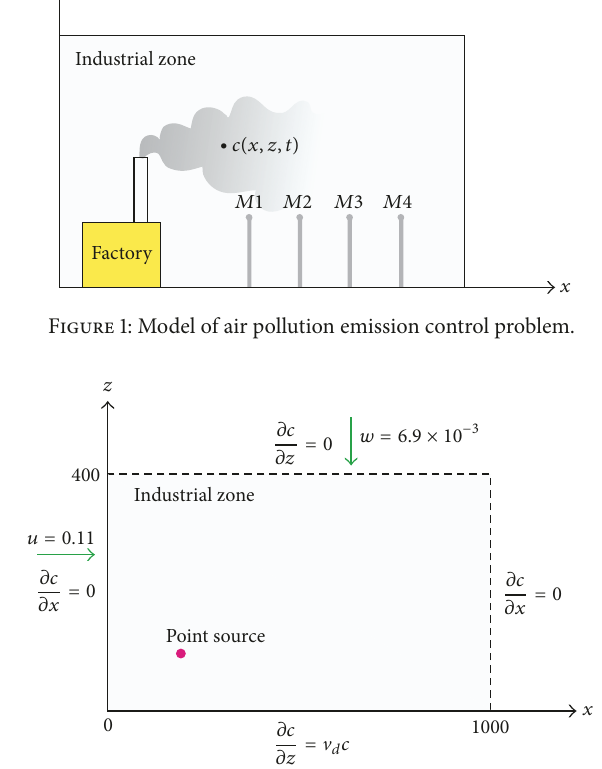
Figure 2: Domain of approximate